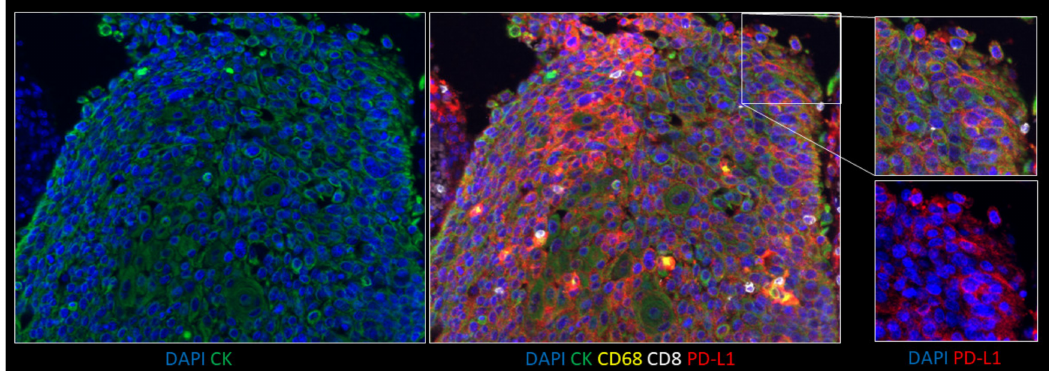
Figure 4. Representative image of fine membrane staining in a squamous cell carcinoma by ULTIVUE multiplex at × 10 magnification. An exploded view of a higher magnification area is shown on the right ( × 20 magnification) with the composite above and DAPI / PD-L1-only channel